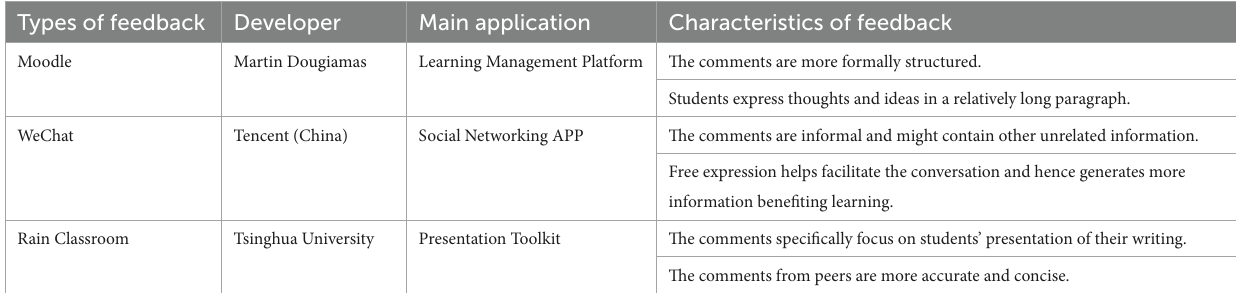
TABLE 2 General information of e-feedback (Rain Classroom, WeChat,